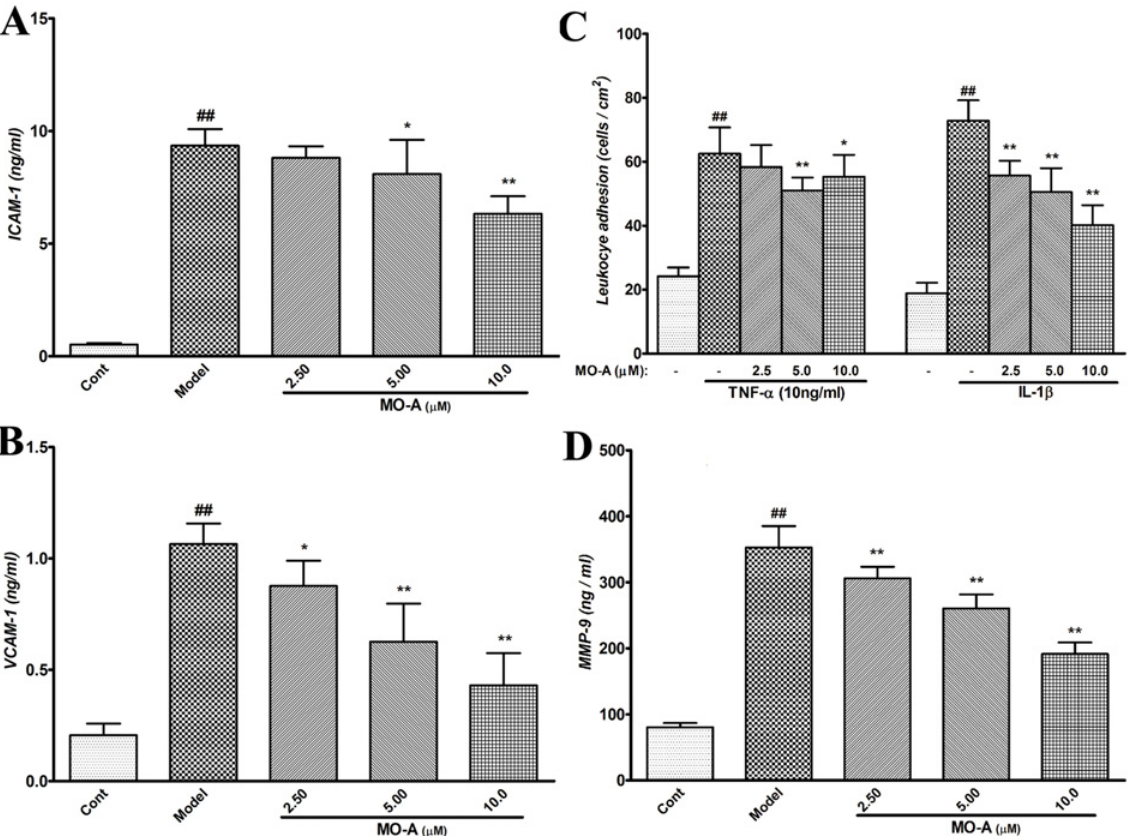
Fig 6. Direct effects of MO-A on the activation of endothelial cells and leukocytes. (A) Expression of ICAM-1 in OGD/R-induced bEnd.3 cells using ELISA, data are shown as Mean ± S.D. (n = 6); (B) Expression of VCAM-1 in OGD/R-induced bEnd.3 cells using ELISA, data are shown as Mean ± S.D. (n = 6); (C) Density of THP-1 cell adhesion to bEnd.3 following stimulation by TNF- α (10 ng/mL) or IL-1 β (10 ng/ml), data are shown as Mean ± S.D. (n = 3); (D) MMP-9 secretion in undifferentiated and differentiated THP-1 cells stimulated by PMA (200 ng/mL) as detected by ELISA, data are shown as Mean ± S.D. (n = 6); # P < 0.05 and ## P < 0.01 vs . sham group by Student ’ s t -test statistical analysis; * P < 0.05 and ** P < 0.01 vs . MCAO model group by one-way ANOVA statistical